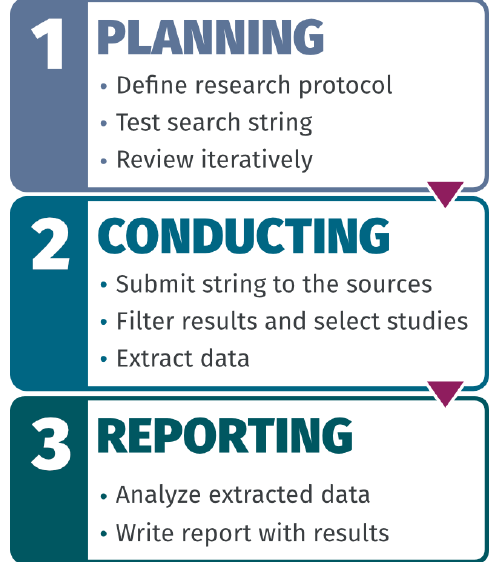
Figure 1. Summary of phases followed in this SM process